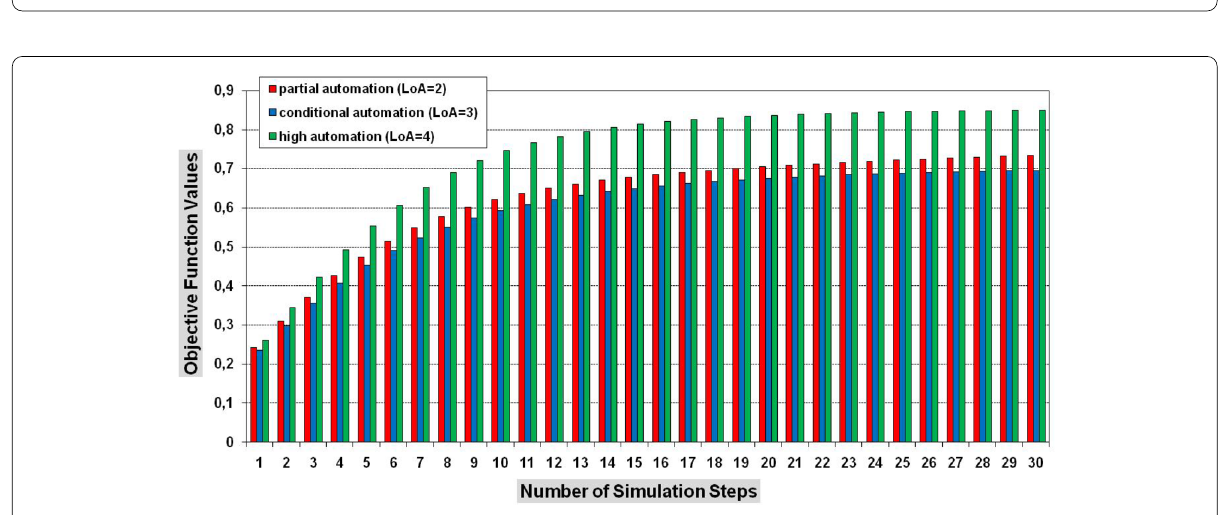
Figure 7 Objective Function values (OFc) for all the available in-vehicle levels of autonomy ( LoA = 2,3 and 4) at the